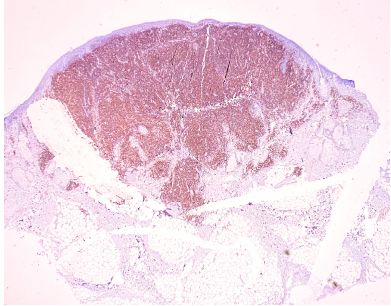
Figure 6. CD4 staining. Magnification 20×. CD8: positive in dispersed T lymphocytes (T cytotoxic lymphocytes) (Figure 7). CD8+ T-cells (often called cytotoxic T lymphocytes) are important for immune defense against intracellular pathogens as well as for tumor surveillance [8].